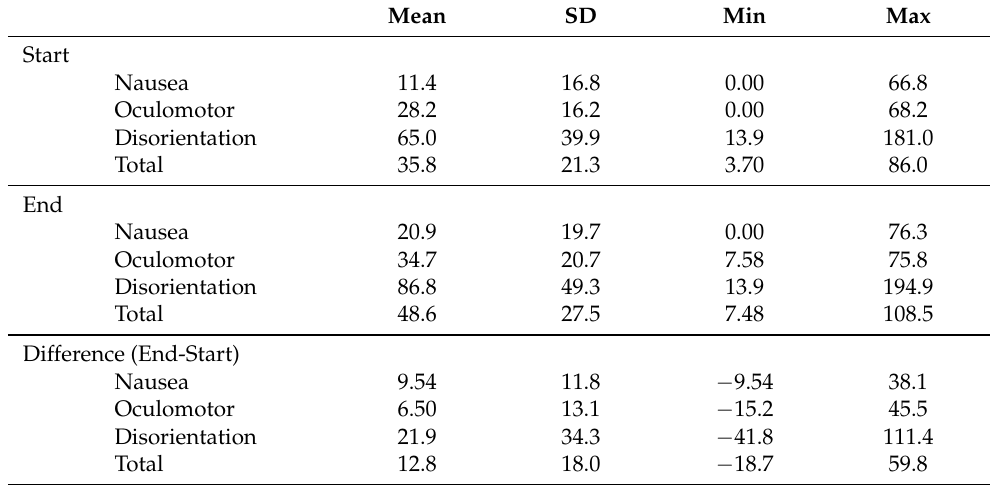
Table 2. Simulator sickness results.